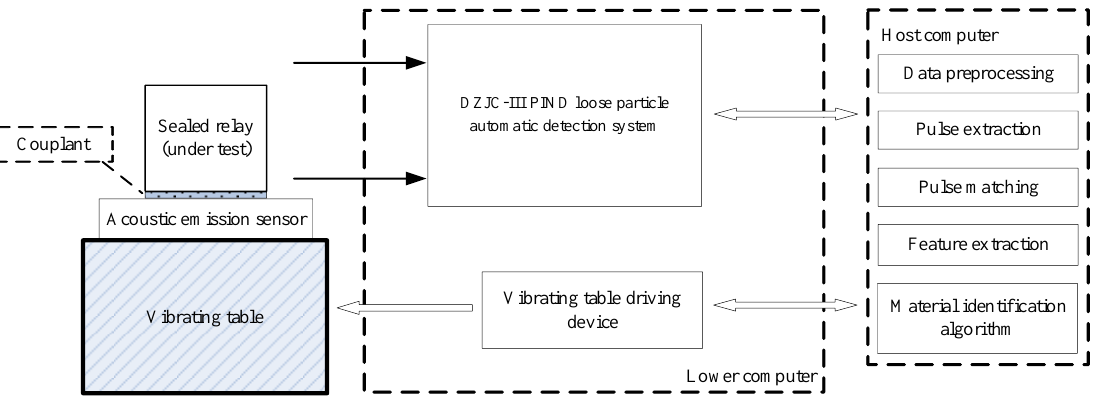
Figure 1. Block diagram of the loose particle material identification experimental system.